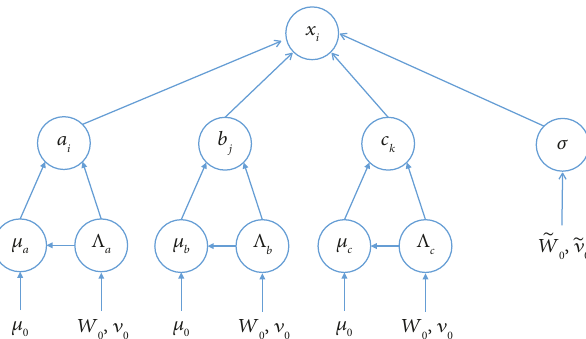
Figure 4: Graphical model for the DTBPD approach with 3 rd -order